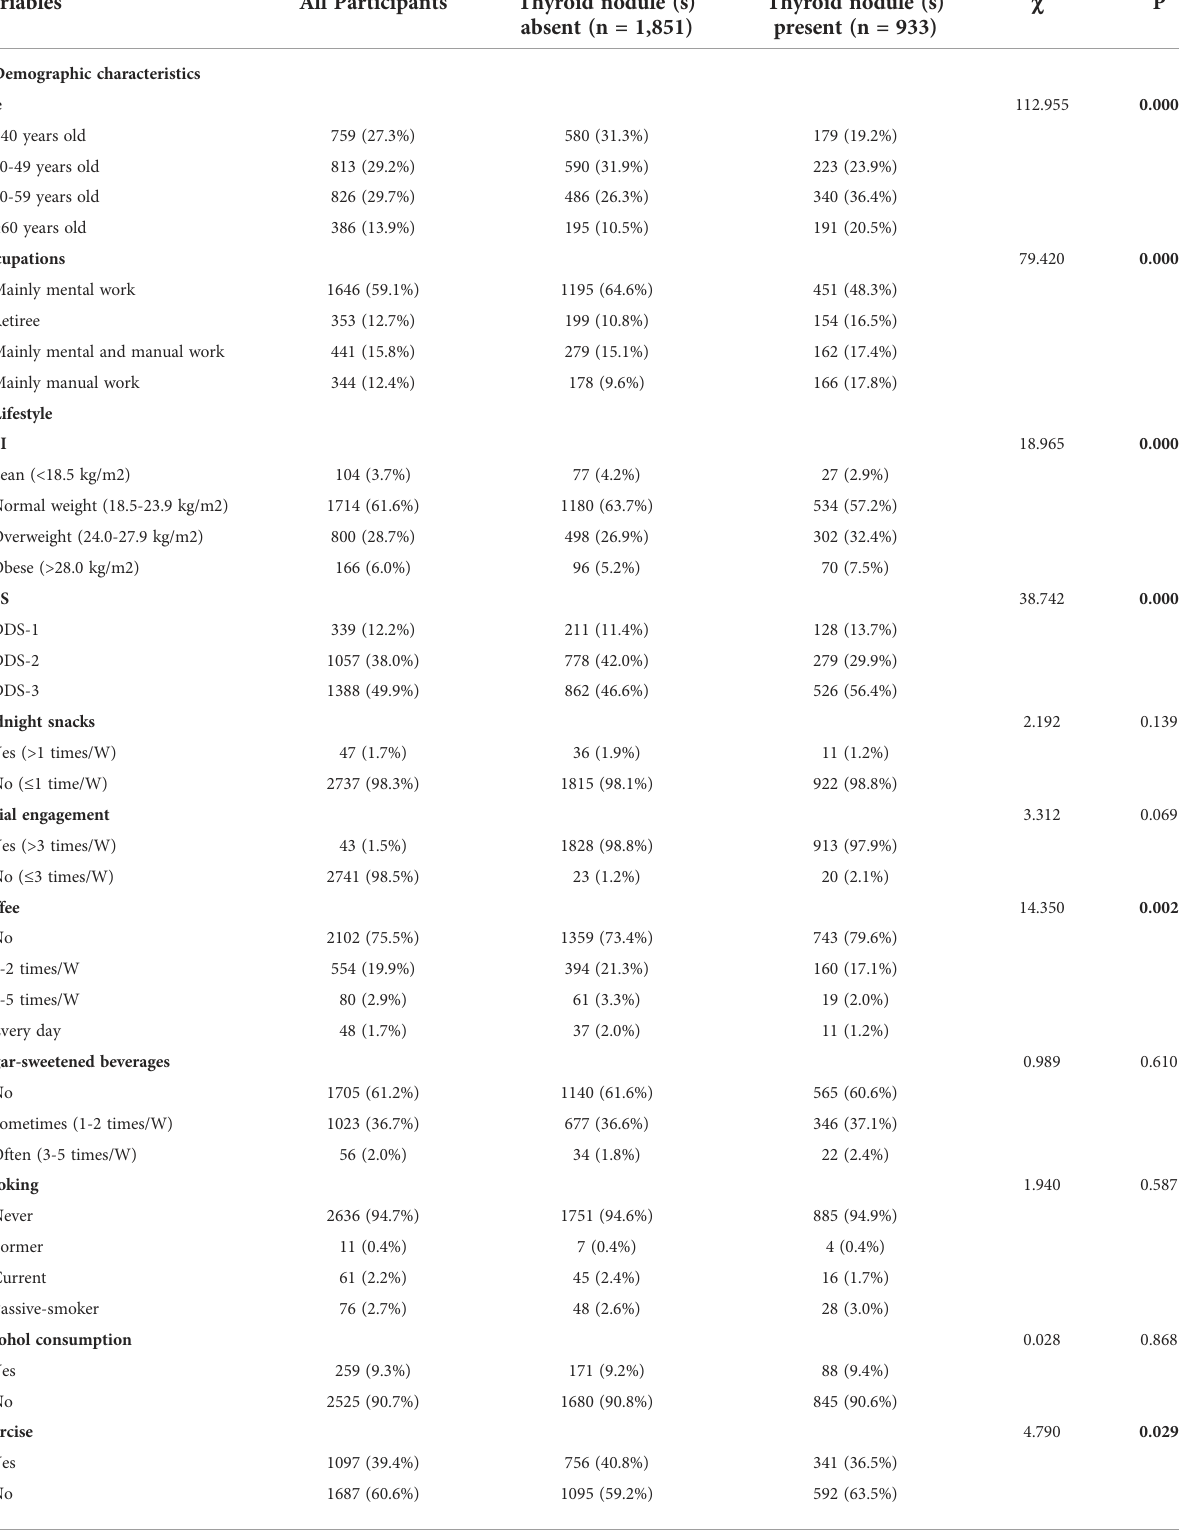
TABLE 1 Demographic characteristics and lifestyle of all participants with and without thyroid nodules (N =